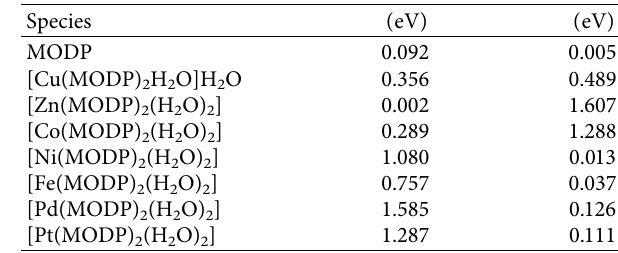
Table 7: Values of λ e and λ h of the different molecules calculated at the PBE0-D3(BJ)/def2-TZVP level of theory in the gas phase. Species λ e ( eV )